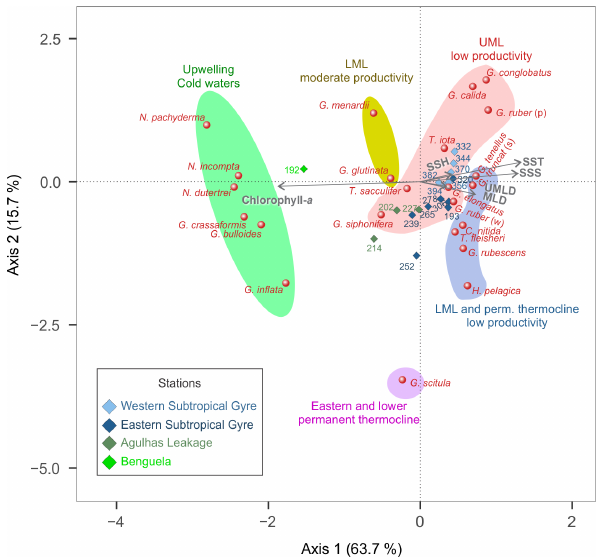
Figure 8. CCA tri-plot of depth-integrated planktonic foraminifera assemblages from the M124 stations showing the position of species with at least 2% in abundance and environmental parameters (UMLD – upper mixed layer depth; MLD – mixed layer depth, com- prising UML and LML; SSH – sea surface height anomaly; SST – sea surface temperature; SSS – sea surface salinity).